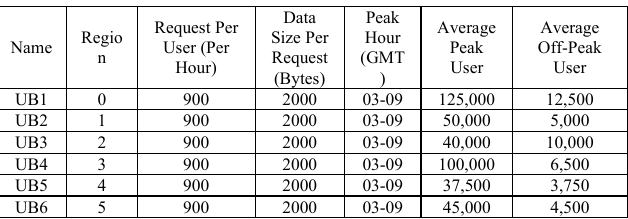
Figure 2(A) response time with different Load balancing Algorithm Using Experiment